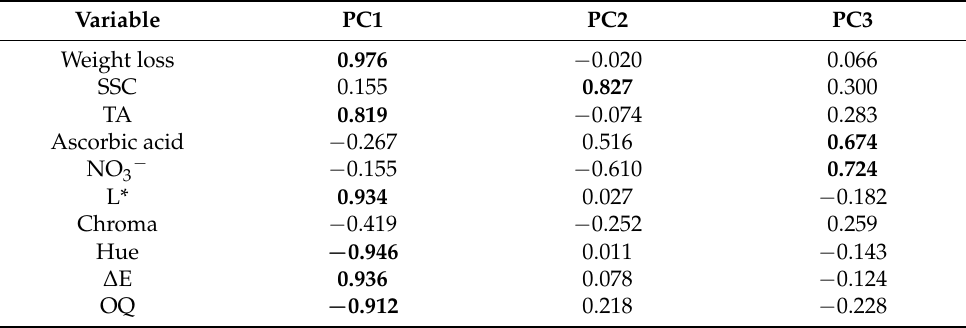
Table 6. Correlation of variables to the factors of the principal components analysis (PCA) based on morpho-physiological and biochemical parameters changes during cold storage of leaf lettuce treated with different Ecklonia maxima extract